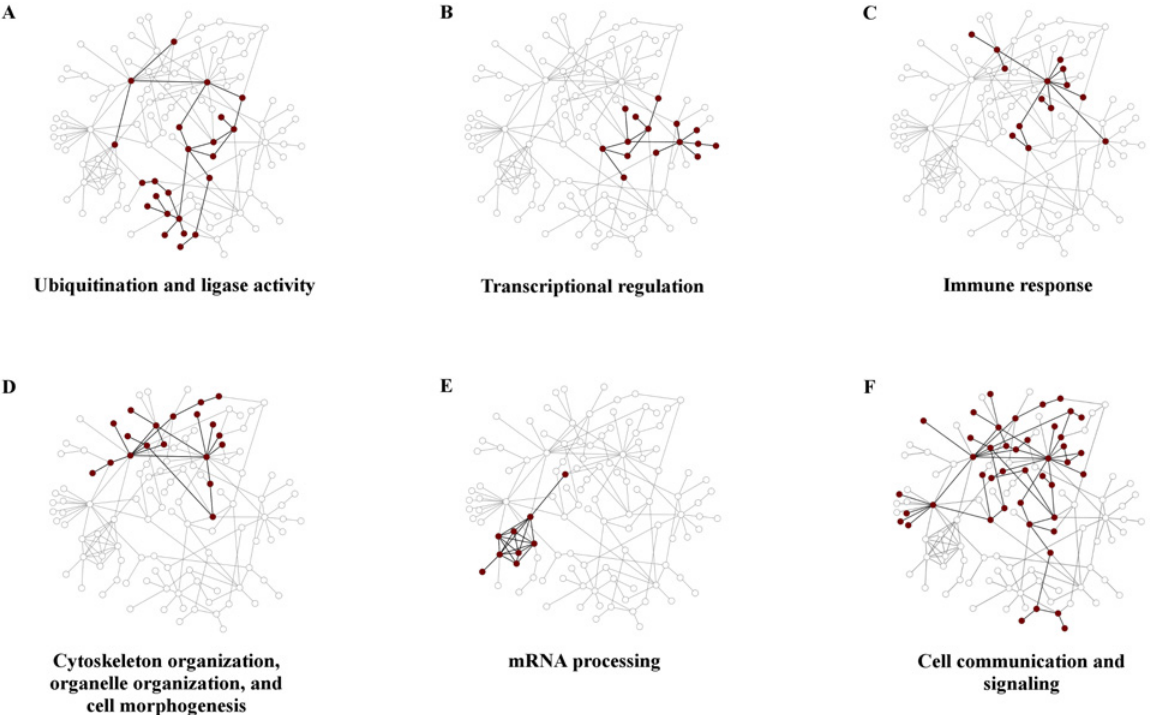
Fig 2. Clustering of human proteins targeted by B. mallei known virulence factors. The graphic shows 116 proteins of the largest connected component of the human PPI network that belong to one or more statistically significant interaction modules. Note that each of these human proteins also interacted with one or more known B. mallei virulence factors. As exemplified by the annotated interaction modules in A-F, the known virulence factors targeted human proteins that were highly interacting among themselves and belonged to the same biological process. For a list of host proteins that compose each interaction module, see S2